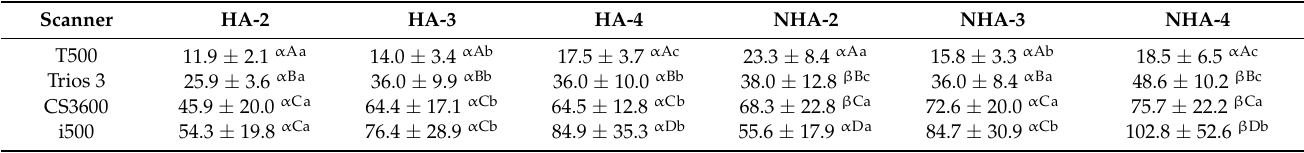
Figure 5. Results of the three-way ANOVAs of precision ( A ) between the groups with different scanners, ( B ) between the groups with or without healing abutment, and ( C ) between the groups with different numbers of missing teeth. The number on the x-axis in panel C stands for the number of missing teeth. Different letters indicate significant differences between two groups. Data are mean and standard deviation values in micrometers. Table 2. Precision values in the HA-2, HA-3, HA-4, NHA-2, NHA-3, and NHA-4 groups for all of the scanners. Eight scans were performed in each group. Data are mean ± standard deviation values in micrometers.